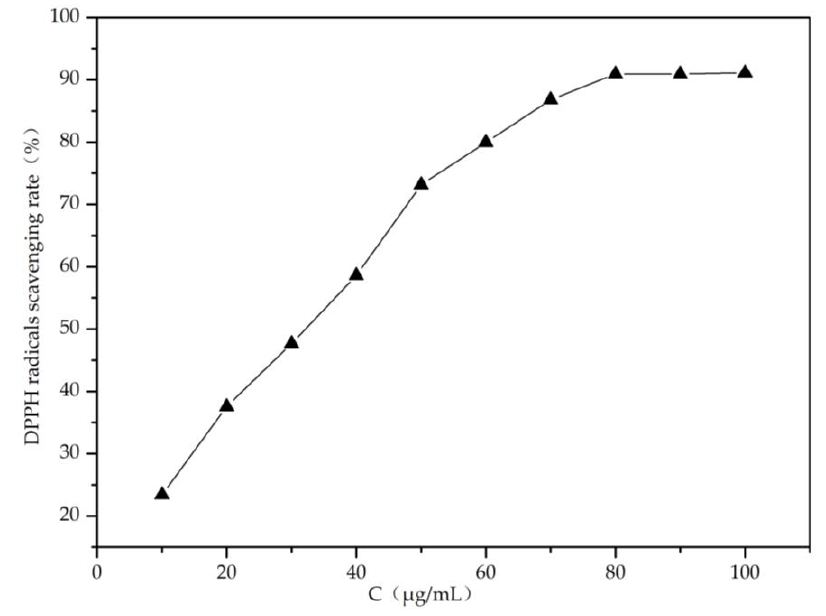
Figure 1. Rate of 1,1-diphenyl-2-picrylhydrazyl (DPPH) radical scavenging by larch bark tannin (LBT) in solution.